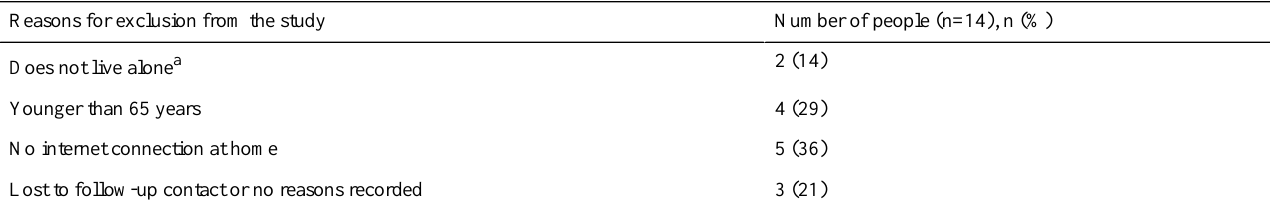
Table 2. Reasons for